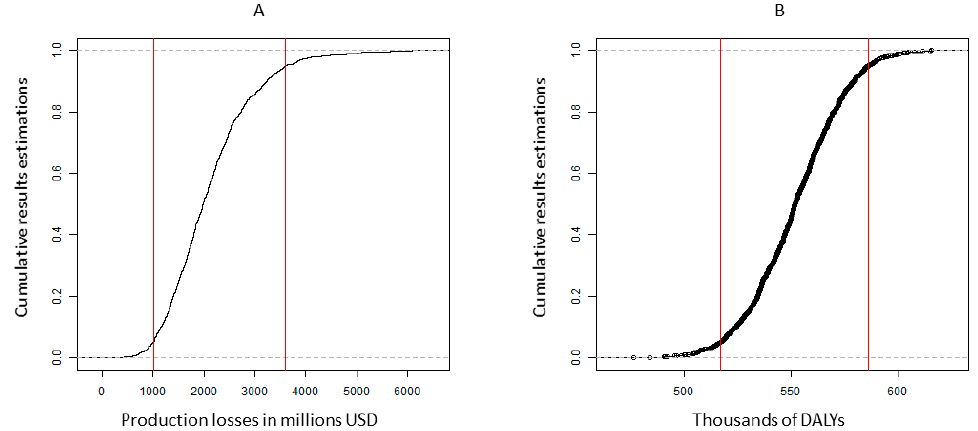
Figure 6. Probabilistic sensitivity analysis by economic and health burden in DALYs (disability- adjusted life years). The lines represent 95% confidence intervals.